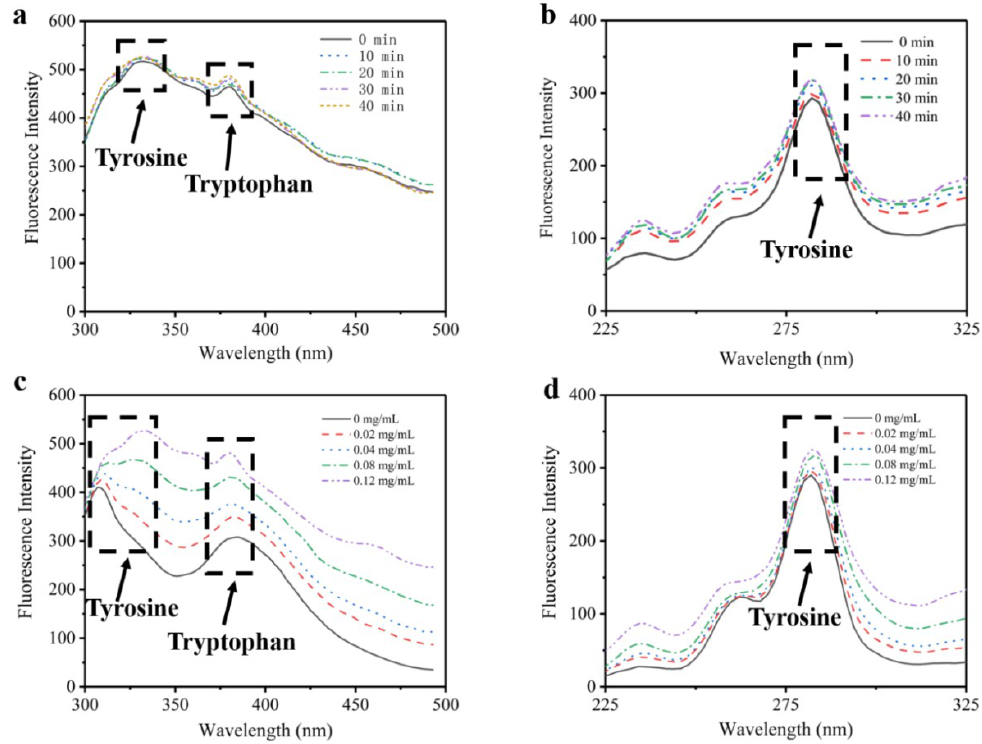
Figure 1. The fluorescence and synchronous fluorescence spectroscopy of type I collagen. ( a ) Changes of tyrosine residues influenced by time with fluorescence spectroscopy. ( b ) Changes of tyrosine residues influenced by time with synchronous fluorescence spectroscopy. ( c ) Changes of tyrosine residues influenced by collagenase I concentration with fluorescence spectroscopy. ( d ) Changes of tyrosine residues influenced by collagenase I concentration with synchronous fluorescence spectroscopy.